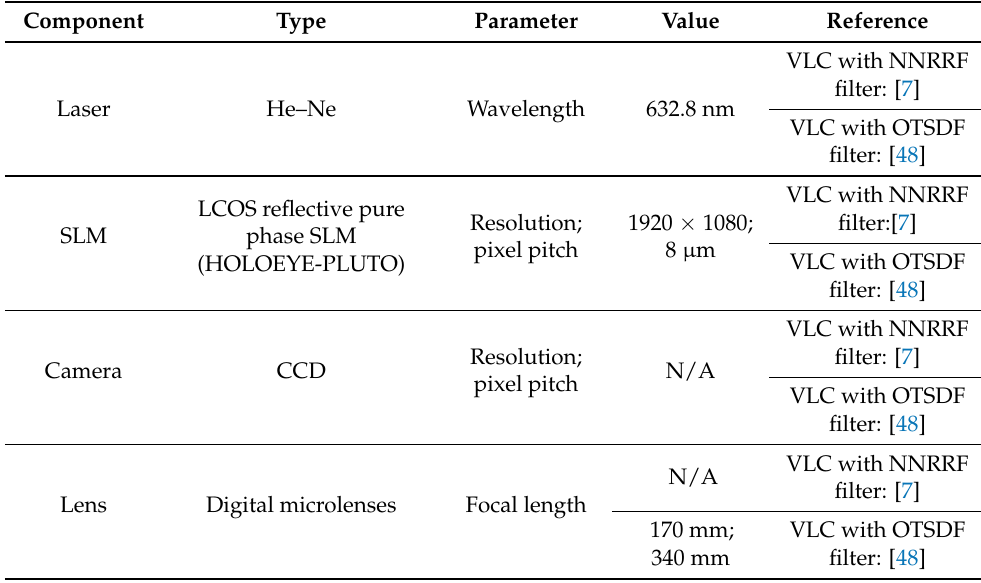
Table 7. Comparison between the most important parameters of the VLC setup in various proposed architectures, for image recognition in different